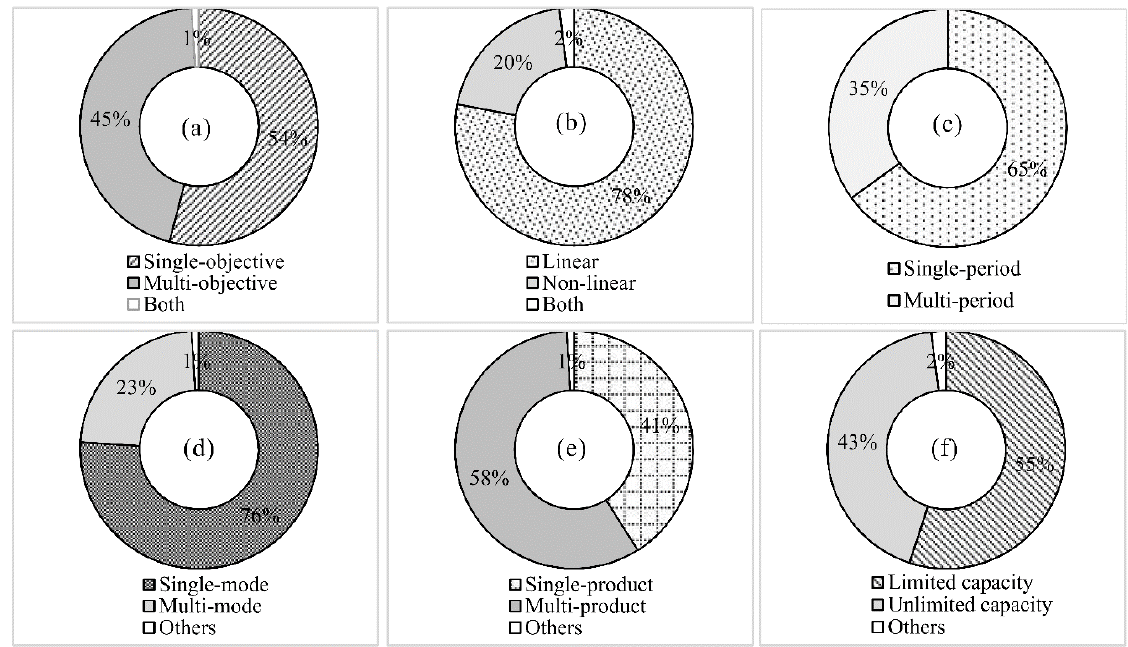
Figure 3. The portion of selected articles in each of sextet